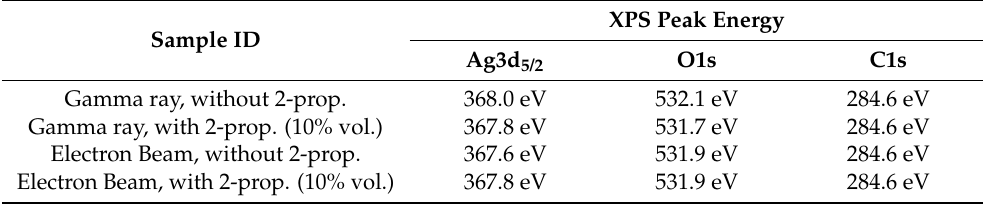
Table 2. Antibacterial activity of Ag/ABS samples against E. coli .